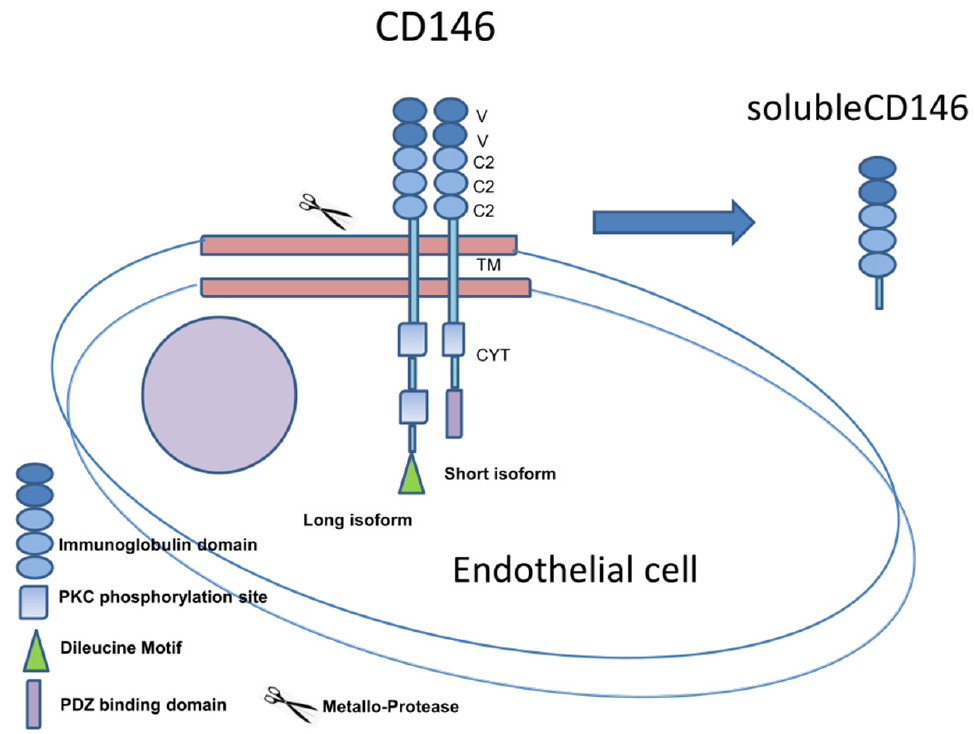
Figure 1. Schematic Representation of CD146 Antigen as membrane protein and soluble isoform. In normal adults, it is expressed in different tissues, and in particular in the different cells constituting the vessels; i.e., endothelial cells, smooth muscle cells, and